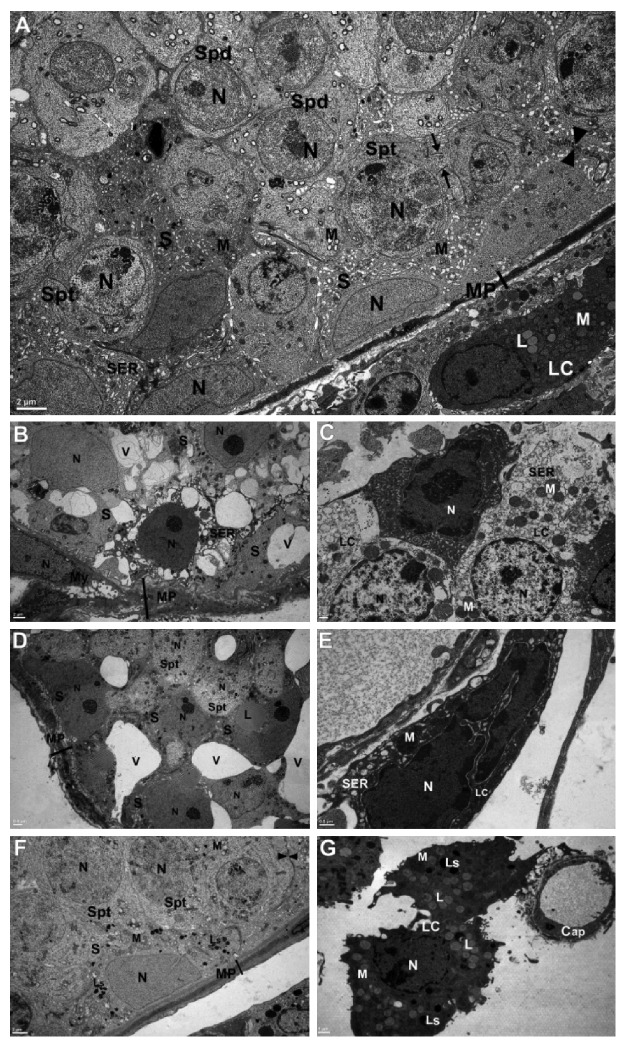
Electron microscopic view of testicular tissue samples of postnatal subjects (Group 1). (a) Membrane propria (MP), Sertoli cells (S), spermatocytes (Spt), spermatids (Spd), and nucleus (N) were seen to be normal in control subjects (Group 1A). Tight connections between the Sertoli cells (arrowhead) were observed as normal like the cytoplasmic bridges (arrows) between the spermatogenic cells. Leydig cells (LC) were seen to have normal tubular-type mitochondria (M) and abundant lipid droplets (L) in their cytoplasm. SER: agranular endoplasmic reticulum; bar = 2 μm. (b) Thick and curved membrane propria (MP) and Sertoli cells (S) containing excessive and abnormal vacuolization (V) were indicated in GnRH-antagonist-administered subjects of Group 1 (Group 1B). My: myoid cells. (c) A decrease in the cytoplasmic volumes of some Leydig cells (LC) and an increase in the peripheral heterochromatin patches in the nucleus (N) were seen in testicular tissue samples of Group 1B. In the cytoplasm of some Leydig cells (LC), low electron density, dense agranular endoplasmic reticulum (SER) vacuolization, and intact mitochondria (M) were noted. Bar = 0.5 μm. (d) Relatively reduced curvature and thickness in the membrane propria (MP) were observed. Giant vacuoles (V) between Sertoli cells (S) and relatively normal spermatocytes (Spt) were seen in GnRH-antagonist-and-osteocalcin-administered subjects of Group 1 (Group 1C). (e) Decreased cytoplasmic volume in Leydig cells (LC) showed an increase in indentation and a decrease in heterochromatin content of the nucleus (N) in testicular tissue samples of Group 1C. In the cytoplasm, it was noted that agranular endoplasmic reticulum (SER) seemed to have vacuolization, but mitochondria (M) remained intact. Bar = 0.5 μm. (f) Sertoli cells (S) and spermatocytes (Spt) were also found to be normal in seminiferous tubules surrounded by normal membrane propria (MP) in only-osteocalcin-administered subjects of Group 1 (Group 1D). The tight junctions between the Sertoli cells (arrowhead) were normal. Ls: lysosome; bar = 1 μm. (g) Increased lipid droplets (L) were observed in the cytoplasm of the Leydig cells (LC), which have decreased heterochromatin content and indentation in the nuclei (N) of testicular tissue samples of Group 1D. Cap: capillary; bar = 1 μm.